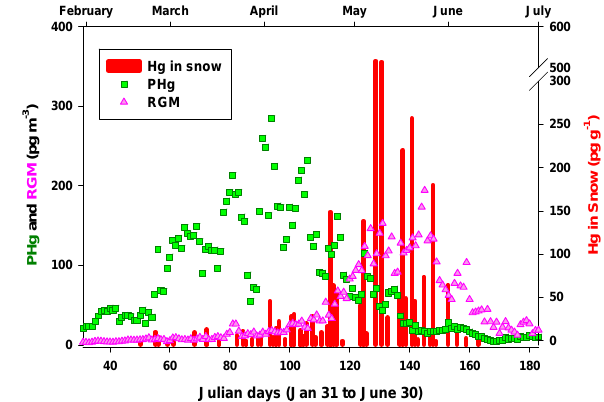
Fig. 8. Atmospheric mercury speciation concentration data PHg and RGM (pgm − 3 ) and Hg concentration (pgg − 1 ) from the snow (ta- ble) from February to June for all data from 2002 to 2011. The at- mospheric data have been averaged per Julian day over all the